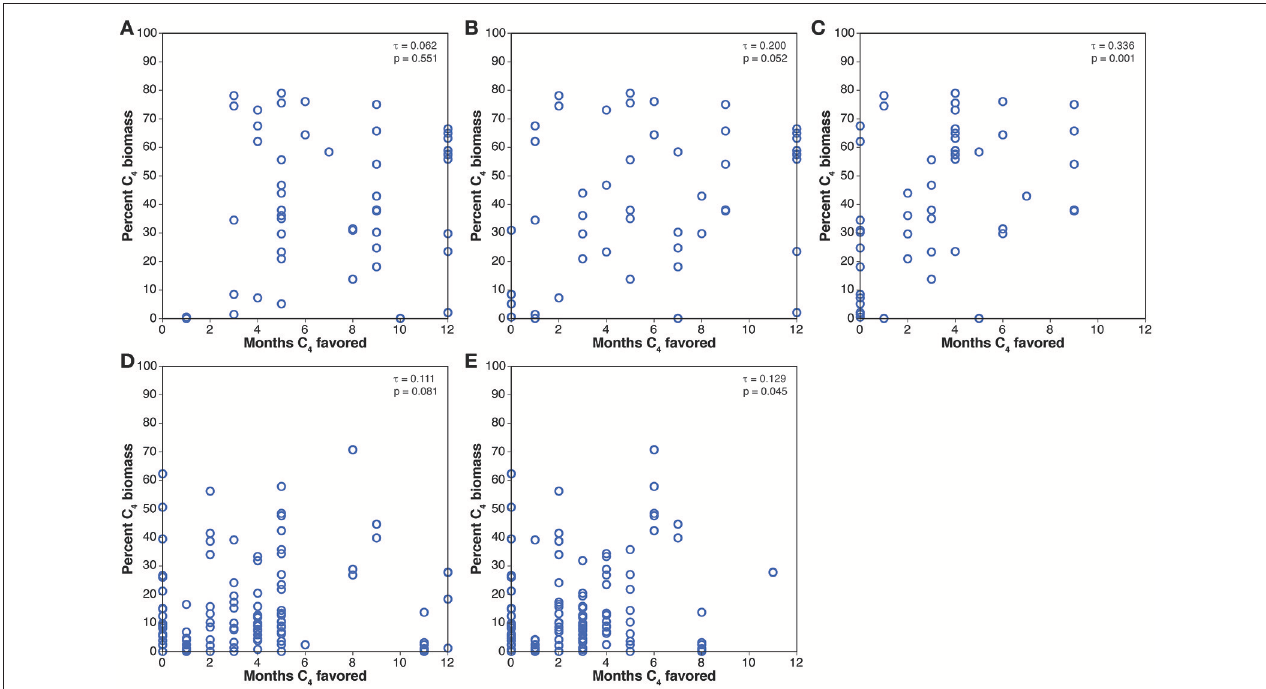
FIGURE 7 | Comparisons of results of the Collatz model to mean estimated percent C 4 biomass from the biomineral compilation. (A) Pliocene, 280 ppmV CO 2 . (B) Pliocene, 405 ppvM CO 2 . (C) Pliocene, 560 ppmV CO 2 . (D) Miocene, 280 ppmv CO 2 . (E) Miocene, 401 ppmV CO 2 .